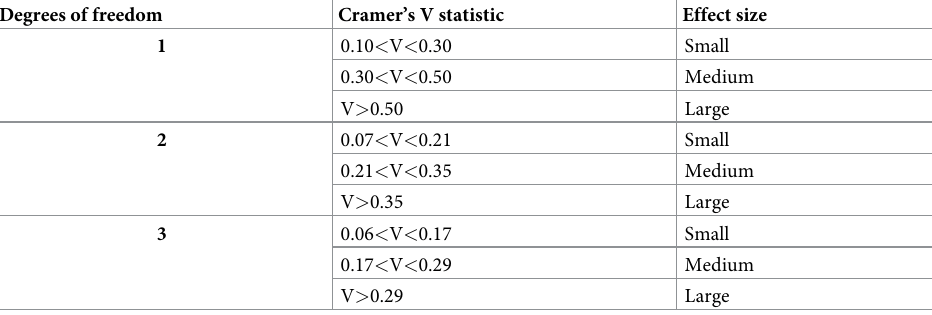
Table 2. Interpretation criteria for Cramer’s V measure of effect size for chi-square contingency tables